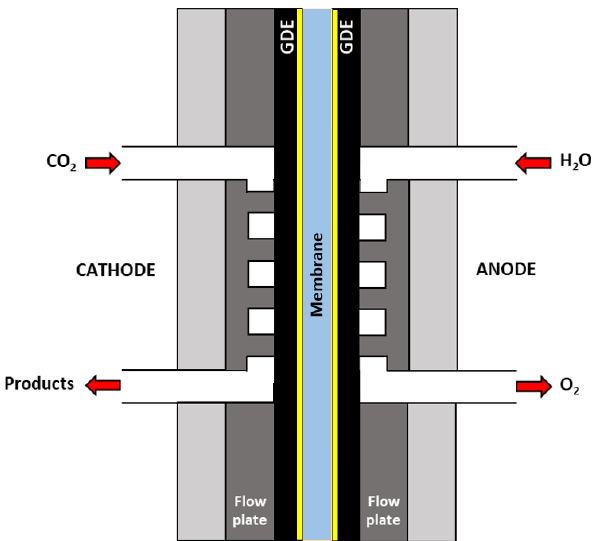
Figure 7. Schematic diagram of a CO 2 polymer electrolyte membrane (PEM) electrolyser. Cathode and anode are both gas diffusion electrodes. The two compartments are separated by an ion-exchange membrane, i.e., a solid-state electrolyte. The catalyst layers shown in yellow are part of the GDEs and are in direct contact with the membrane. The stack GDE/membrane/GDE is also called a membrane electrode assembly.